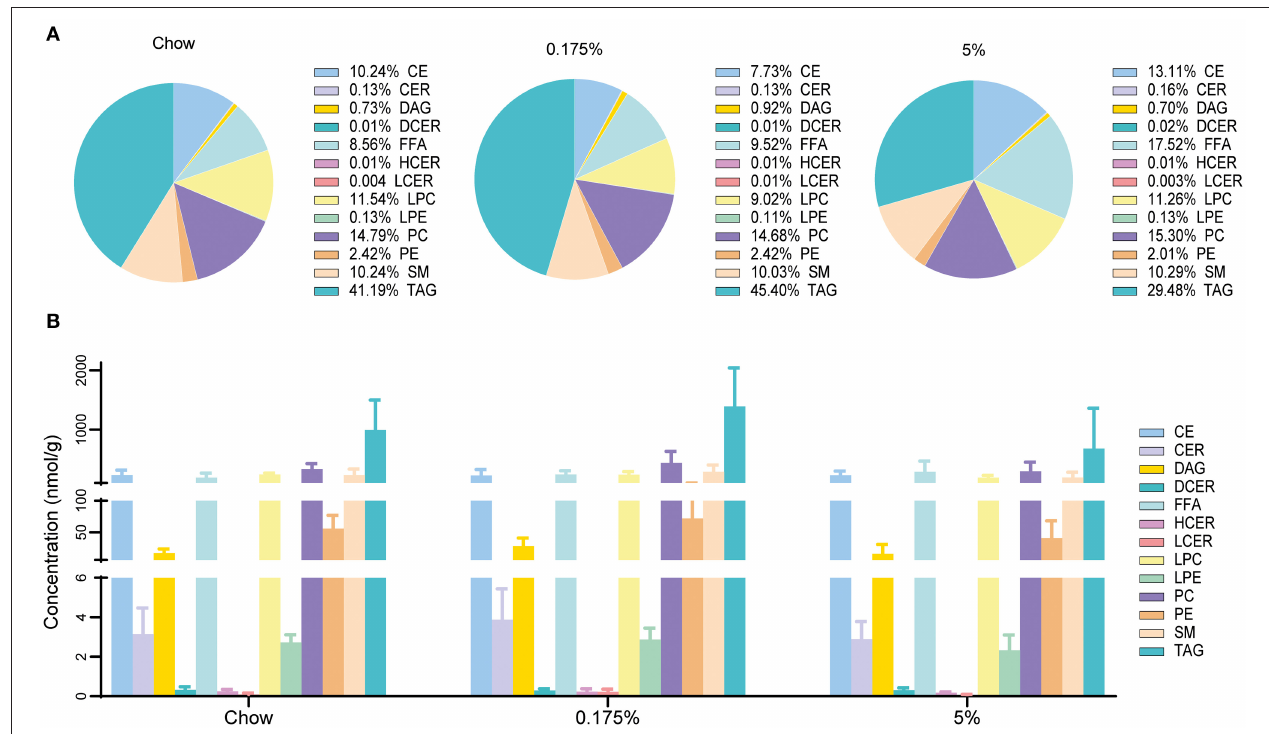
FIGURE 2 | Lipid classes in plasma from rabbits fed chow, 0.175% and 5% lard diet groups. (A) . Proportion of lipid classes. (B) . Lipid class concentrations. CE, cholesteryl esters; CER, ceramides; DAG, diacylglycerols; DCER, dihydroceramides; FFA, free fatty acids; HCER, hesoxylceramides; LCER, lactosylceramides; LPC, lysophosphatidylcholines; LPE, lysophosphatidylethanolamines; PC, phosphatidylcholines; PE, phosphatidylethanolamines; SM, sphingomyelins; TAG, triacylglycerols.